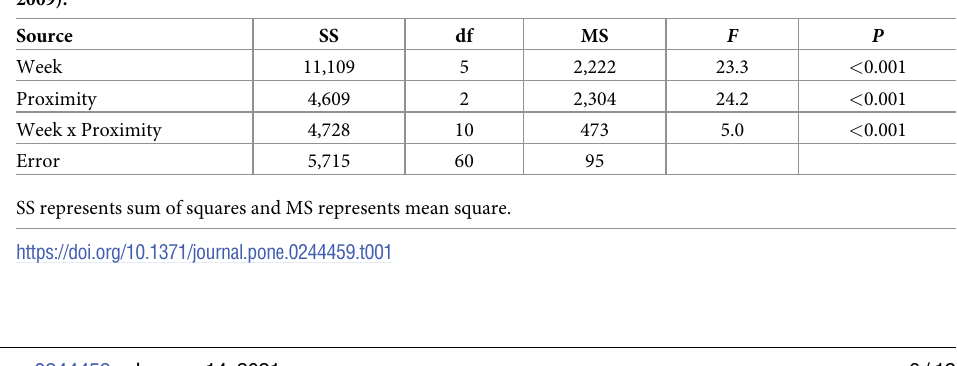
Table 1. Results of a 2-way analysis of variance (ANOVA) showing effects of survey week and proximity (0–3, 3–6, > 6 km) to active falcon nest on red knot density (birds/km) along the Virginia barrier islands in (2006– 2009).